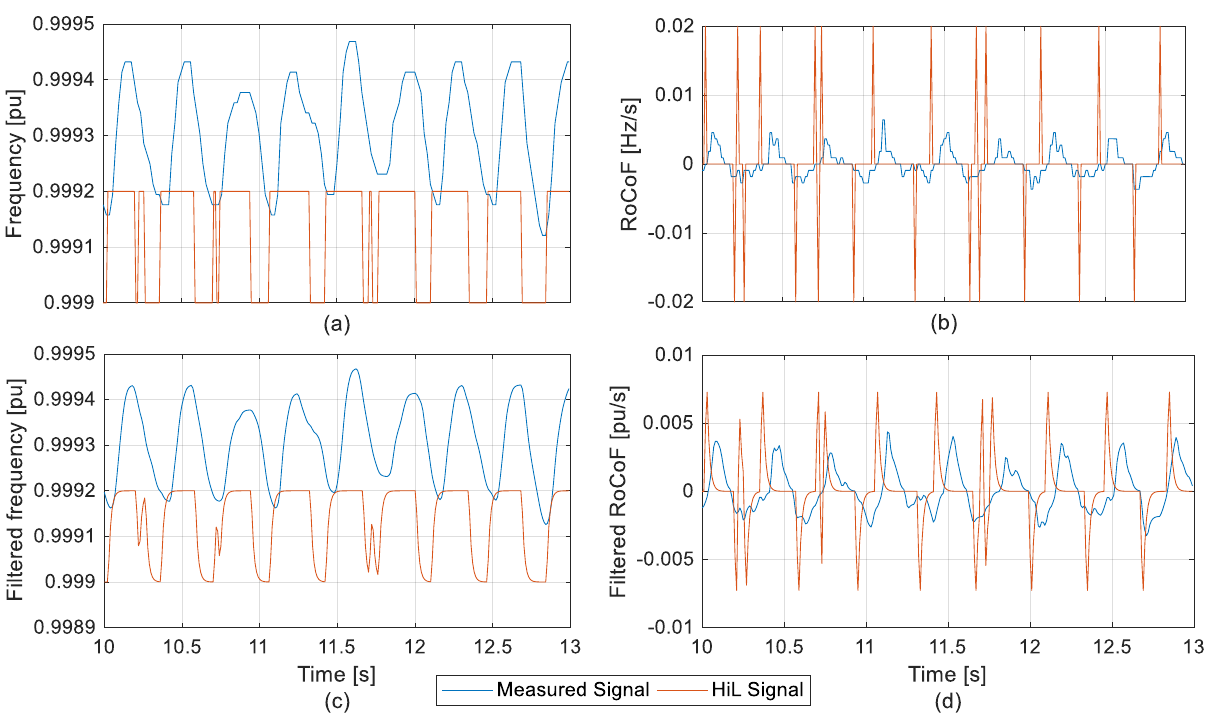
Figure 10. Comparison of the original frequencies and RoCoFs (blue) and HiL signals (orange) for a part of the time trace of scenario 2. ( a ) Shows the originally measured and the HiL frequency, ( b ) the corresponding RoCoFs to the signals in ( a ), ( c ) filtered version of the originally measured and the HiL frequency, and ( d ) the corresponding RoCoFs to the signals in ( c ). Time axes of ( c , d ) are valid for the above subplots as well.